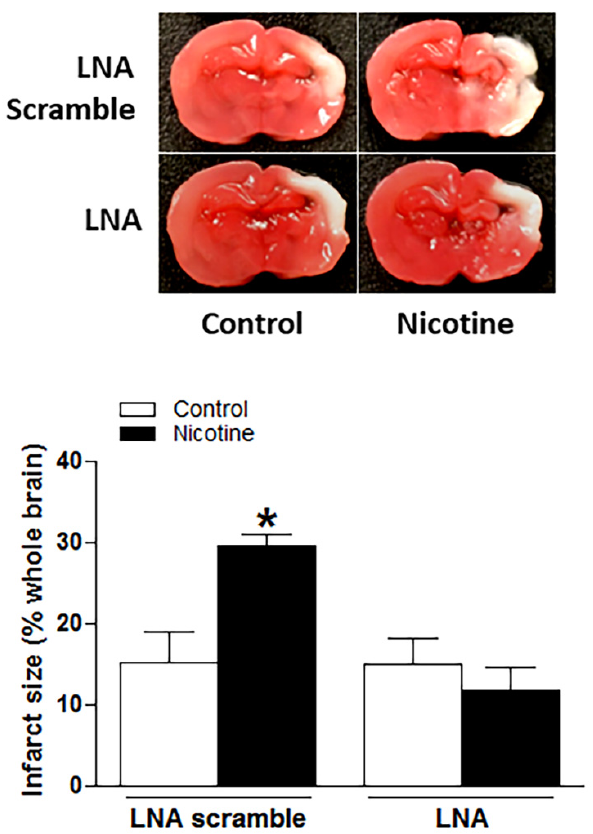
Figure 3. Inhibition of miR-181a reversed nicotine exposure-mediated increases in H/I-induced brain injury in neonatal offspring. Locked nucleic acid (LNA)-MiR-181a antisense and LNA scramble were administered intracerebroventricularly (i.c.v.) on P7 offspring in both saline and nicotine exposed groups. H/I procedure was conducted on P9 offspring. Brain infarct size was determined by TTC staining 48 h after H/I procedure. As presented in this figure, nicotine exposure significantly increased H/I-induced brain infarct size in LNA scramble treated animals while inhibition of miR- 181a via its LNA abolished nicotine exposure-mediated enhanced infarct size in neonatal rat brain. Data are means ± SEM. * p < 0.05, control vs. nicotine. n = 8–12